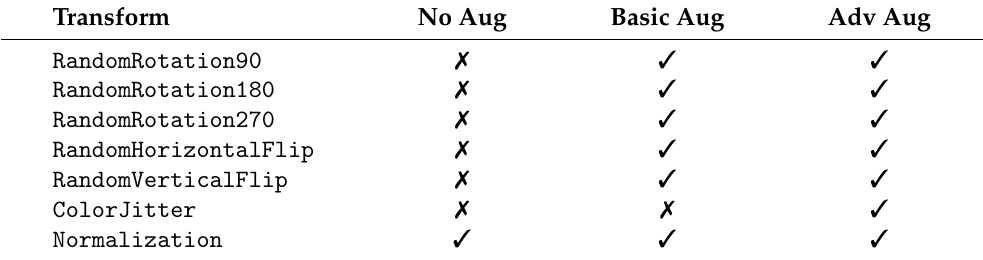
Table 1. Data augmentation summary. All augmentations are carried out on the fly with 0.25 probability in the order they are presented in the table. ’No Aug’, ’Basic Aug’ and ’Adv Aug’ stand for ’No Augmentation’, ’Basic Augmentation’ and ’Advanced Augmentation’. The (cid:51) and (cid:55) symbols mean that the transform is included or excluded, respectively. Normalization is always performed at after all other augmentations. ColorJitter refers to the random alterations of the brightness , range: [ 0.8,1.2 ] ; contrast , range: [ 0.8,1.2 ] ; saturation , range: [ 0.8,1.2 ] ; and hue , range: [ − 0.2,0.2 ]